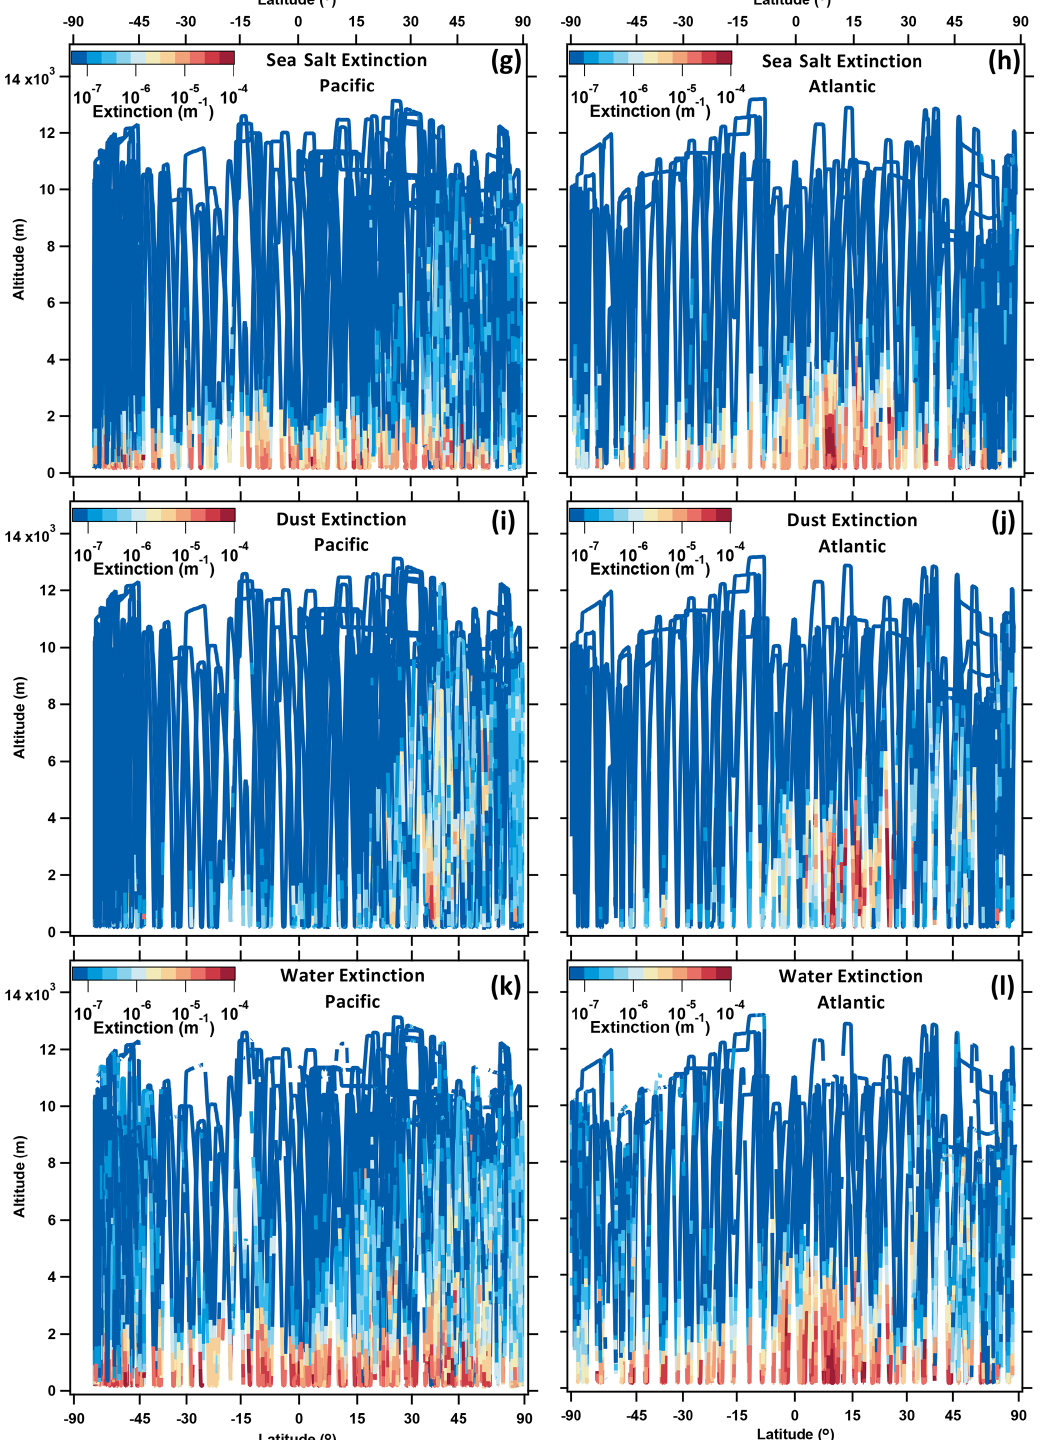
Figure 5. Altitude as a function of latitude color-coded by extinction for all ATom deployments. The x axis is scaled to be proportional to the Earth’s surface area. The left column shows measurements made over the Pacific Ocean, western Arctic, and Southern Ocean; the right column is over the Atlantic, eastern Arctic, and Antarctic Peninsula (see Fig. 1). (a, b) Total ambient extinction; (c, d) dry extinction from biomass burning particles; (e, f) dry extinction from mixed sulfate–organic particles; (g, h) dry extinction from sea salt particles; (i, j) dry extinction from dust particles; (k, l) extinction from water associated with all particle types based on the κ -Köhler hygroscopic growth model.